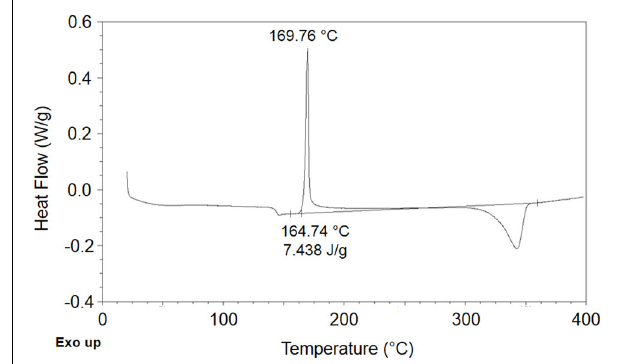
FIGURE 2 | Trace of DSC scan performed on PEEK